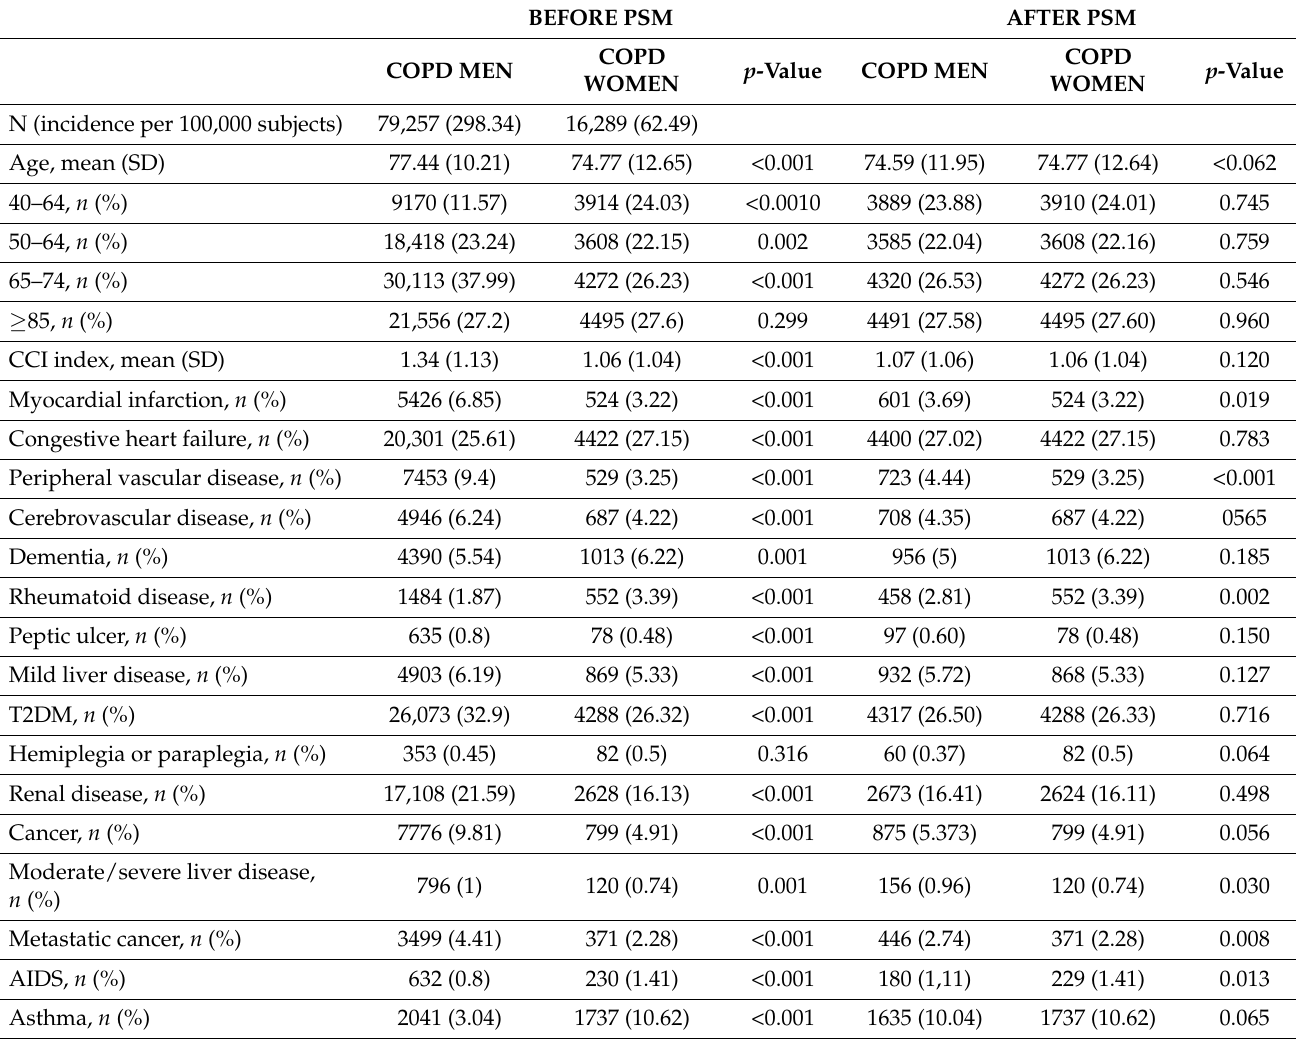
Table 4. Incidence, age distribution, Charlson comorbidity index, concomitant diseases and hospital outcomes for men and women suffering chronic obstructive pulmonary disease admitted to Spanish hospitals from year 2016 to 2019 with community-acquired pneumonia. Results before and after propensity score